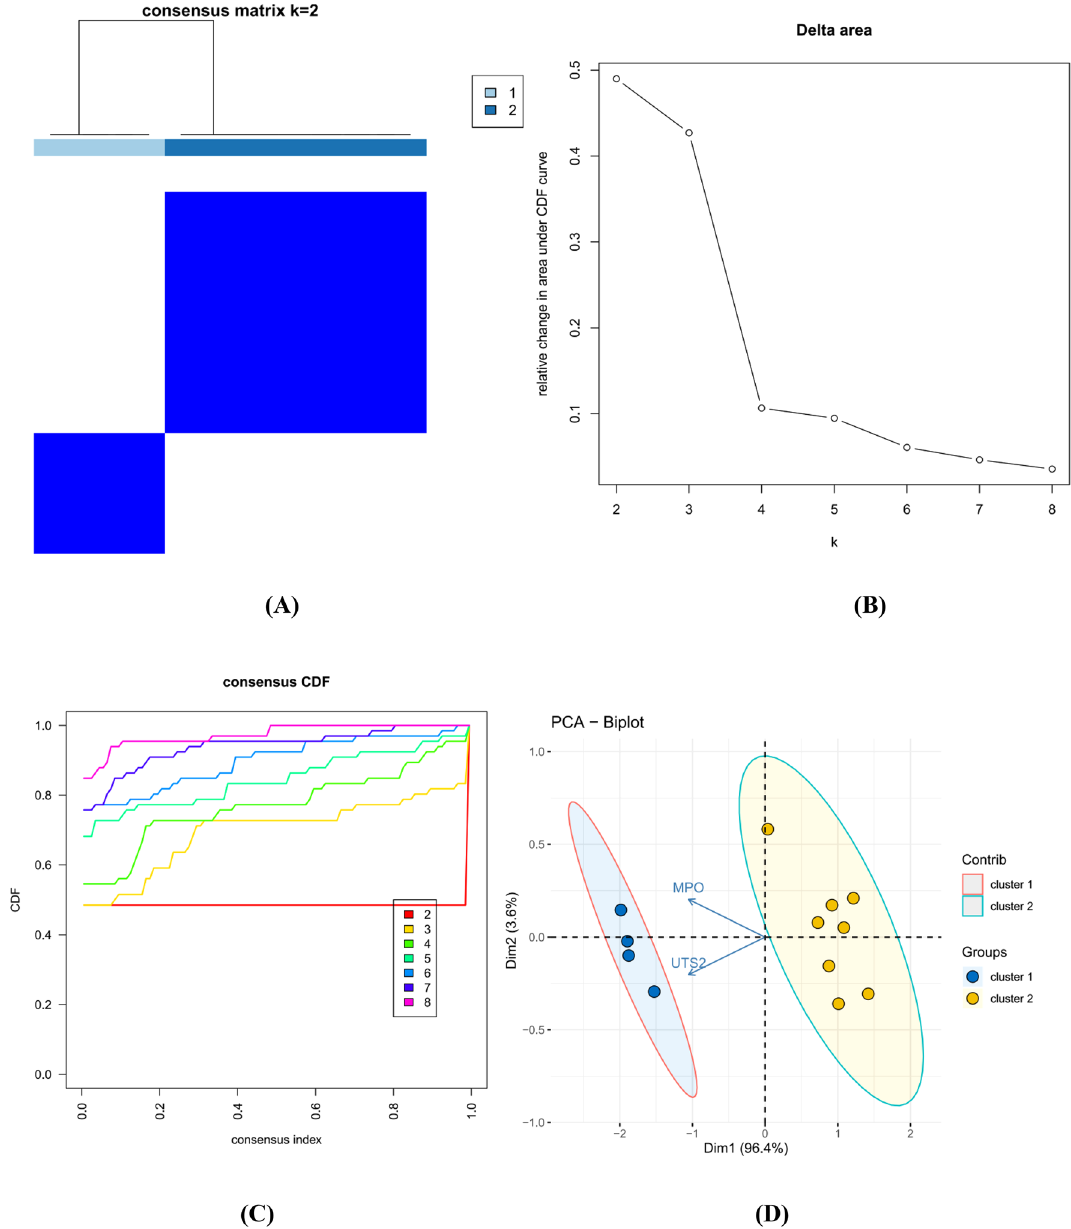
Figure 7. Identification of consensus clusters by the two CNO-related autoinflammatory genes. ( A ) Consensus matrix of autoinflammatory genes when k = 2. ( B ) Relative change in the area under the cumulative distribution function (CDF) curve for k values from 2 to 8. ( C ) CDF plot when the k value ranges from 2 to 8. ( D ) PCA of the two autoinflammatory genes in the CNO